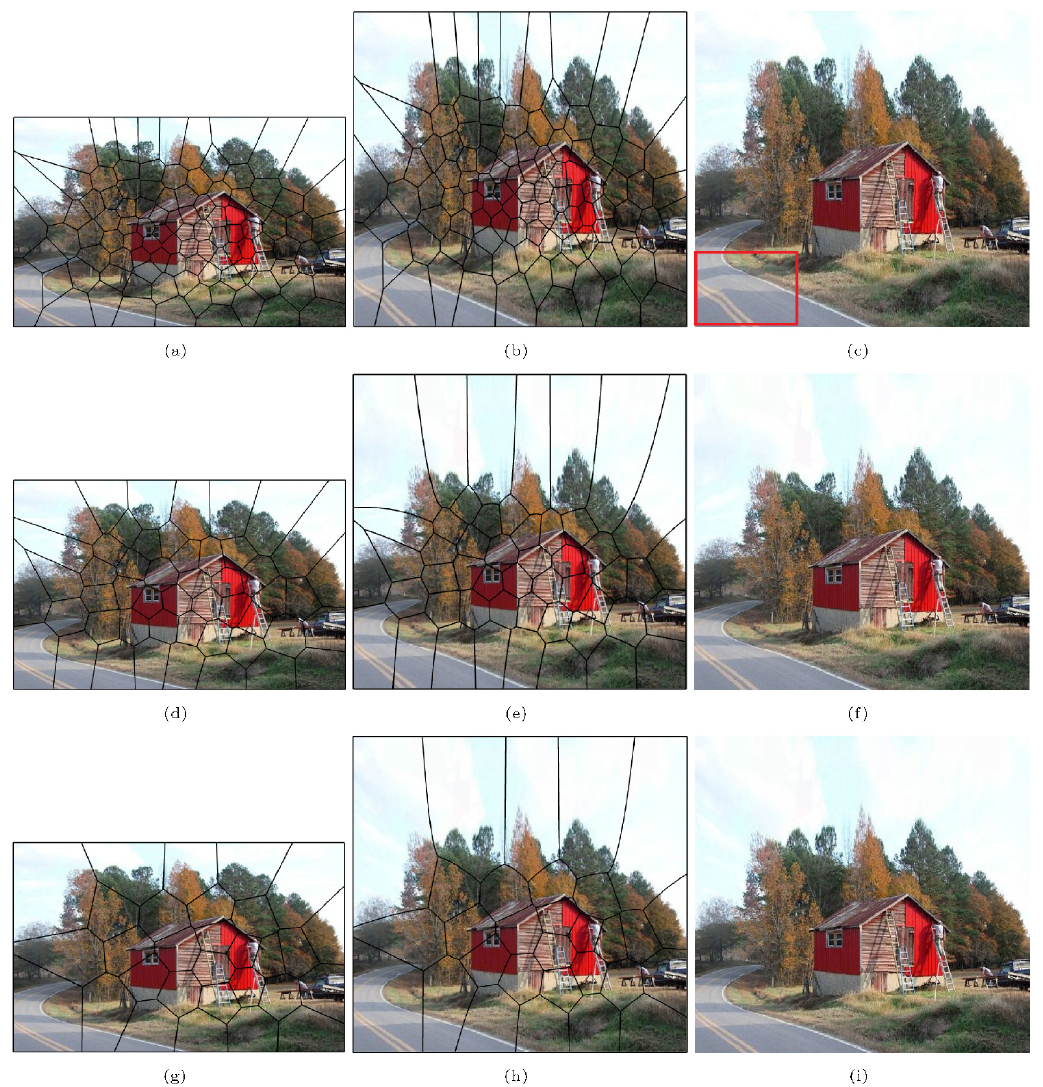
Fig. 7 Comparison of linear and quadratic poly-FEM warping. We resize the image to 150% of its original height. Left to right: adaptive polygonal meshes, deformed polygonal meshes, and final warped images, respectively. (a–c) Linear poly-FEM warping with 100 polygonal elements and 462 DOFs. (d–f) Quadratic poly-FEM warping with 50 polygonal elements and 460 DOFs. (g–i) Quadratic poly-FEM warping with 30 polygonal elements and 280 DOFs.